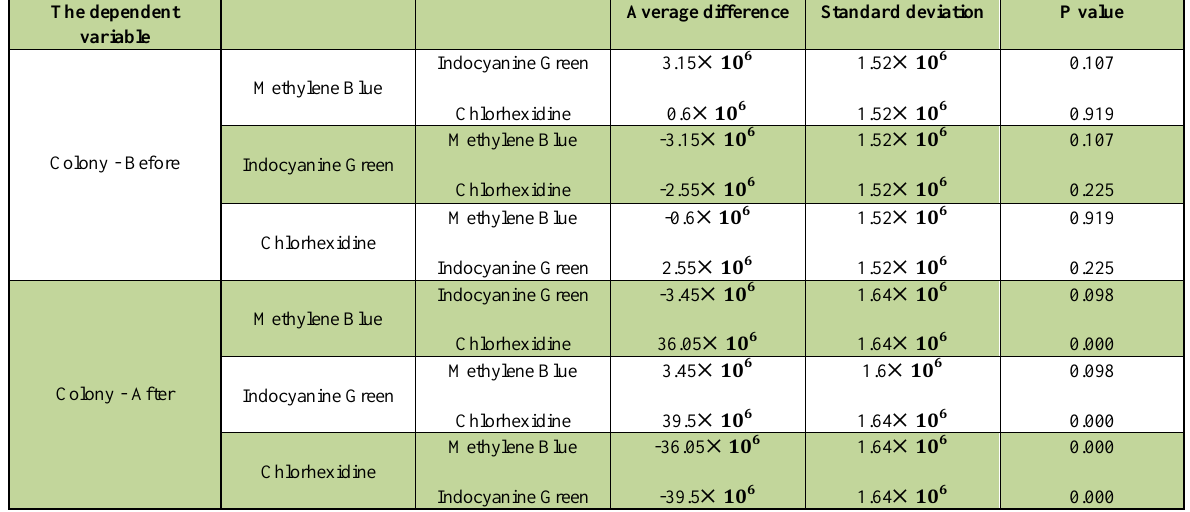
Table 2: Comparison of two groups of Staphylococcus Aureus colony count before and after treatment according to Post Hoc analysis. The